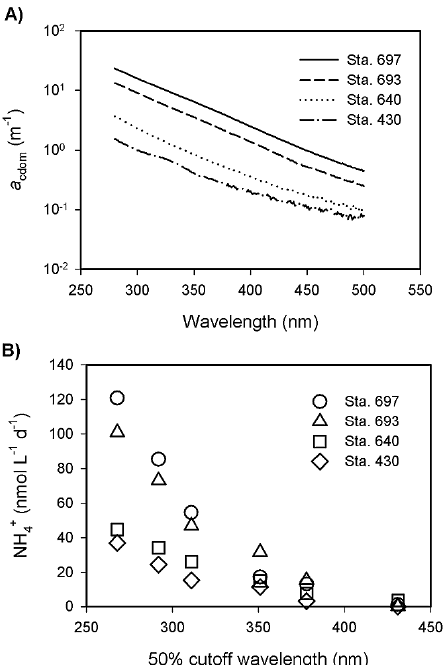
Fig. 4. Typical CDOM absorption spectra (A) and their correspond- ing NH + photoproduction rates as a function of cutoff wavelength 4 observed from laboratory irradiations (B) .